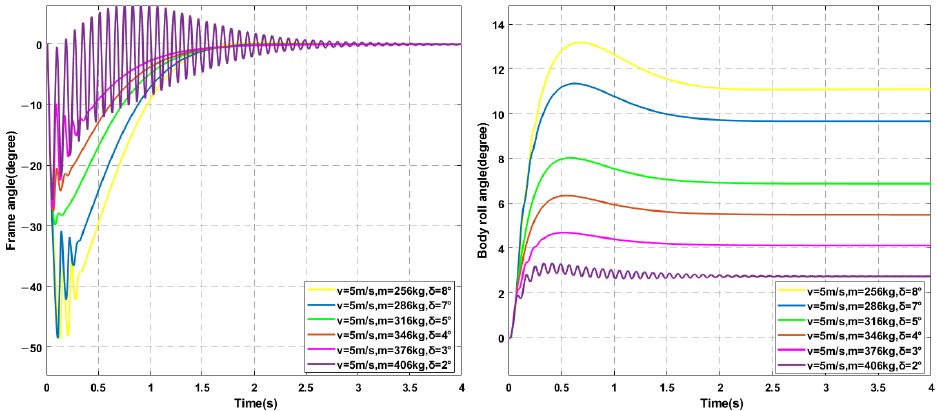
Figure 13. Simulation results: Robustness analysis of vehicle dynamics.